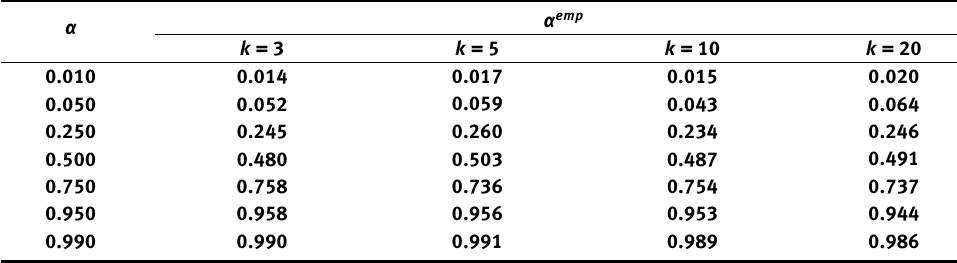
Table 2. Empirical significance levels α emp for HLEs